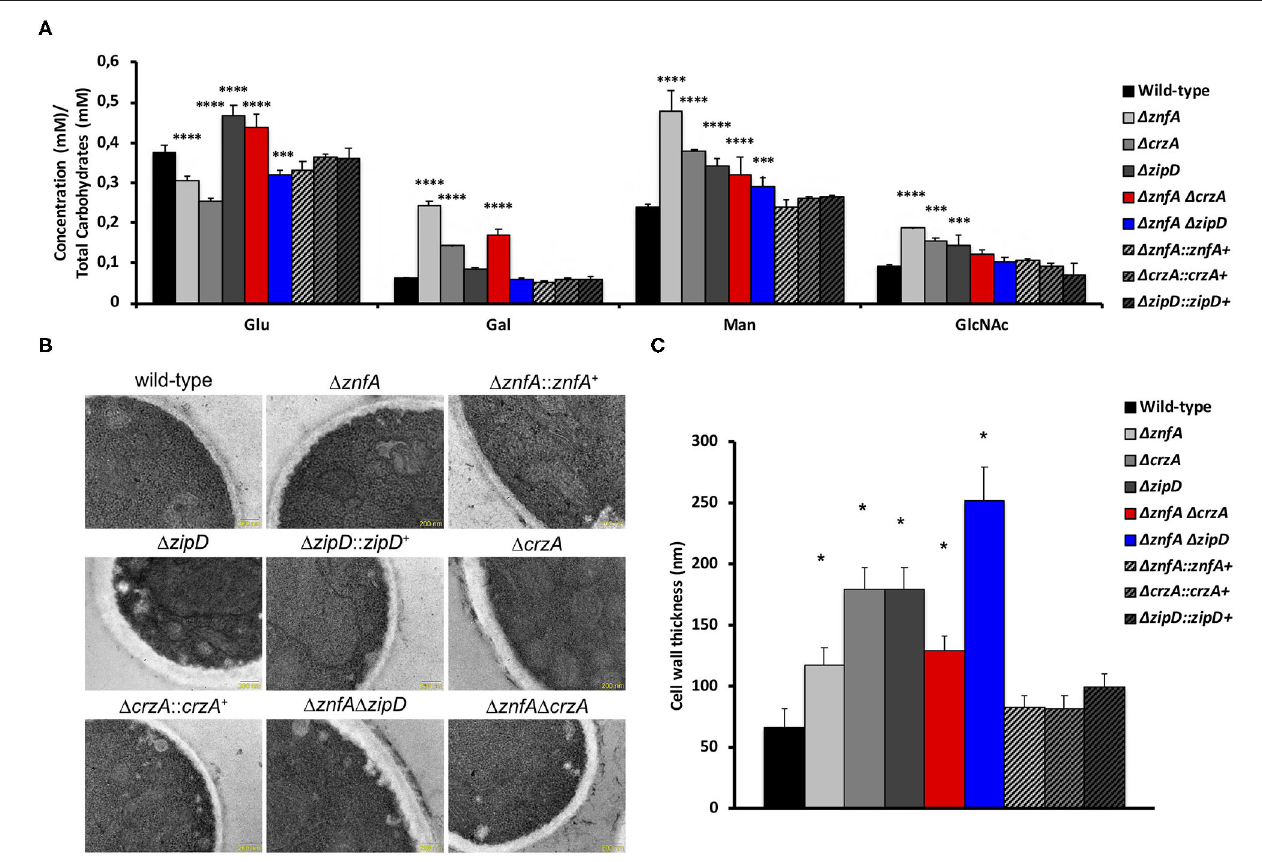
FIGURE 5 | A. fumigatus ZnfA, CrzA and ZipD transcription factors are required for the correct organization of the cell wall. (A) Cell wall sugar content as determined by high performance liquid chromatography (HPLC), in mycelial extracts of A. fumigatus strains included in this work when grown for 16h in MM at 37 ◦ C. Standard deviations represent three biological replicates and statistical analysis was performed using Two-way ANOVA test followed by Dunnett’s multiple comparison test (*** P < 0.001; **** P < 0.0001). Glu, Glucose; Gal, Galactose; Man, Mannose; GlcNAc; N-acetyl Glucosamine. (B) TEM images of mycelial sections of wild-type, 1 znfA , 1 znfA::znfA + , 1 zipD , 1 zipD::zipD + , 1 crzA , 1 crzA::crzA + , 1 znfA 1 zipD and 1 znfA 1 crzA strains mycelia grow in MM at 37 ◦ C. Magnification bars: 200nm. (C) The cell wall thickness of 100 sections from different germlings was measured and plotted on the graph. Average ± SD are shown. Statistics were determined by one-way ANOVA with a Dunnett’s multiple comparison test. Asterisks indicate significant differences between each mutant strain compared to the wild-type strain (* p <